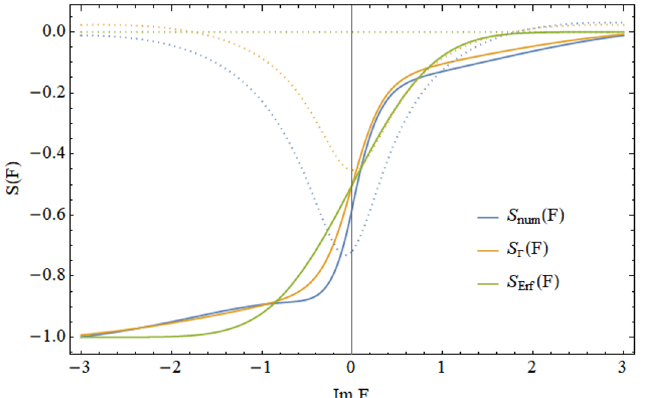
Figure 2 . The comparison between | C 2 | and e − Re F with 0 < Re F ≤ 2 , and the vertical axis is in logarithmic scale.